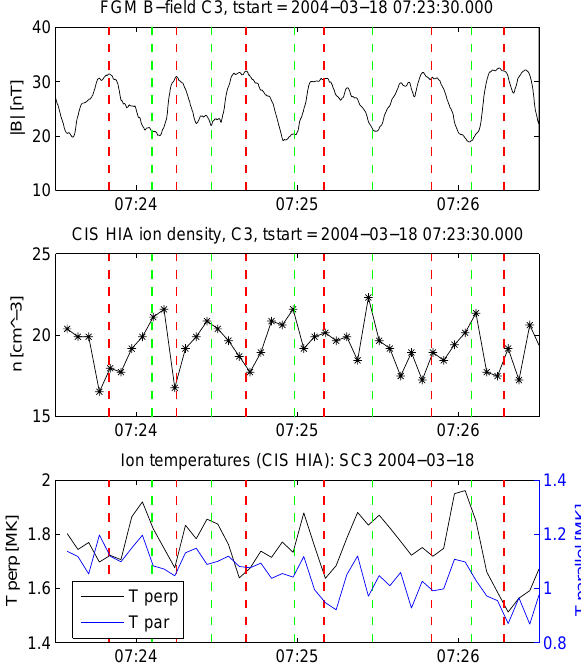
Fig. 1. Magnetic field and ion data for the studied interval from Cluster 3. Top: magnetic field (FGM), Center: ion density (CIS – HIA), Bottom: Perpendicular and Parallel ion temperatures (CIS – HIA). The vertical dashed lines mark the positions of peaks and troughs for easier